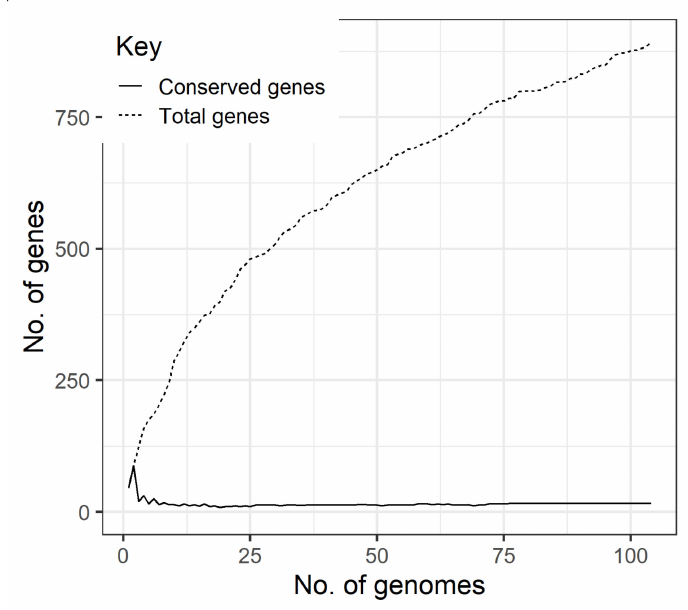
Figure 3. Pan-genome of K. pneumoniae prophages. The size of the core genome (continuous line) and pan-genome (dashed line) as more genomes are